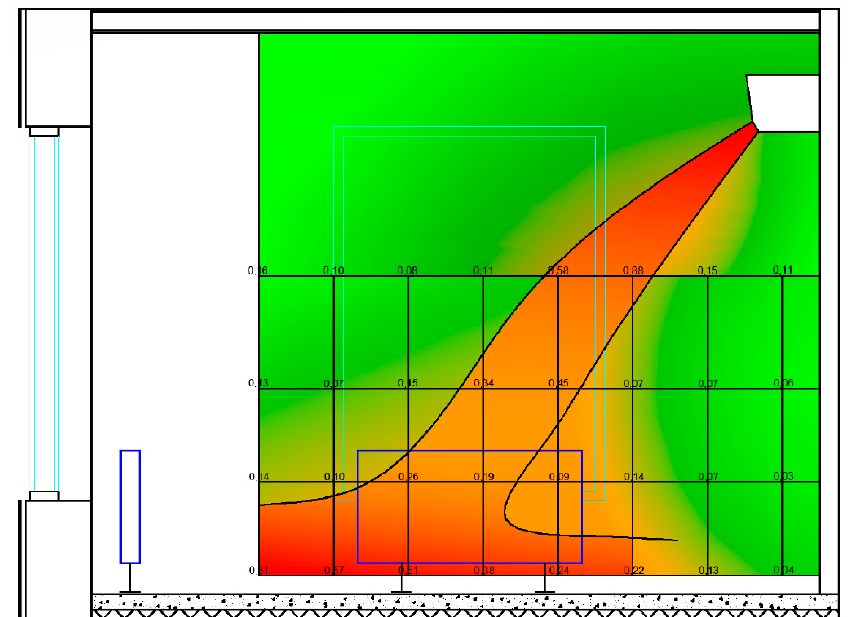
Figure 20. Visualization of the air jet velocities for the FCU unit.